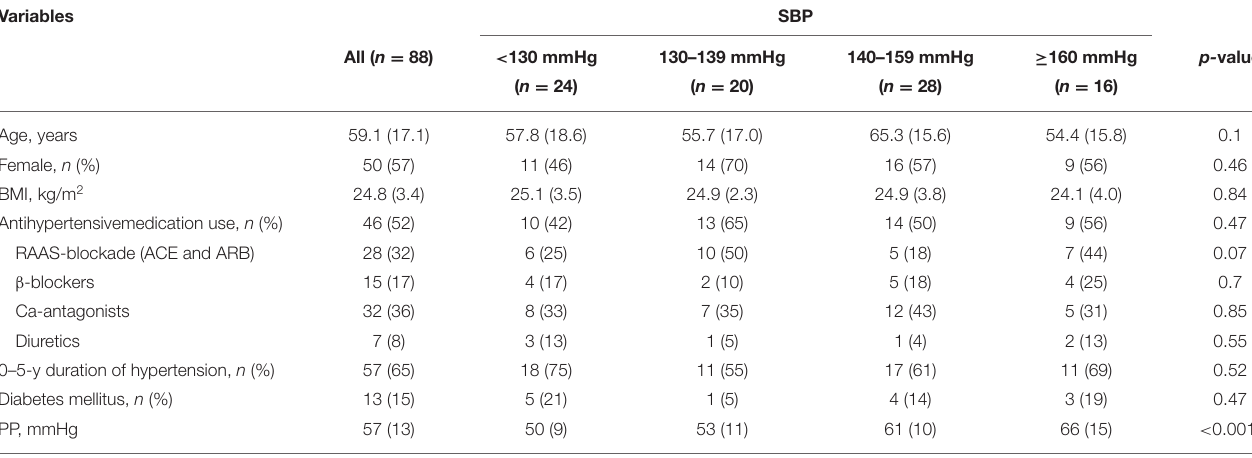
TABLE 1 | Clinic characteristics of patients by blood pressure categories.